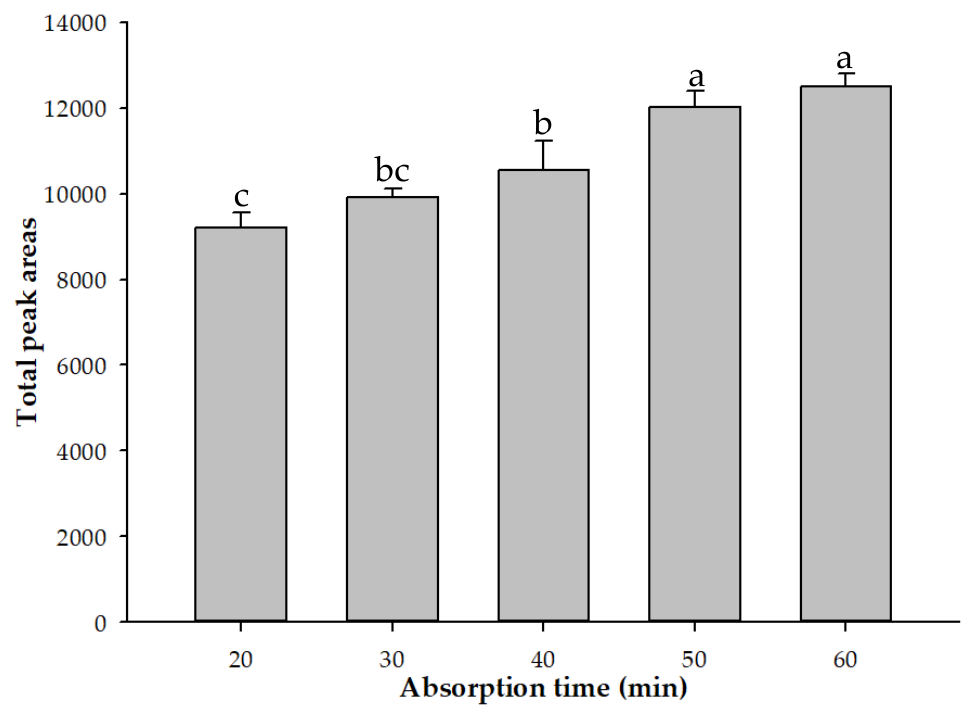
Figure 3. Comparison of the contents of the total volatiles in Hekei-140 at different absorption times using HS-SPME. The data correspond to the mean ± SD of triplicate experiments. a–c : Values possessing different superscripts are significantly different ( p < 0.05).